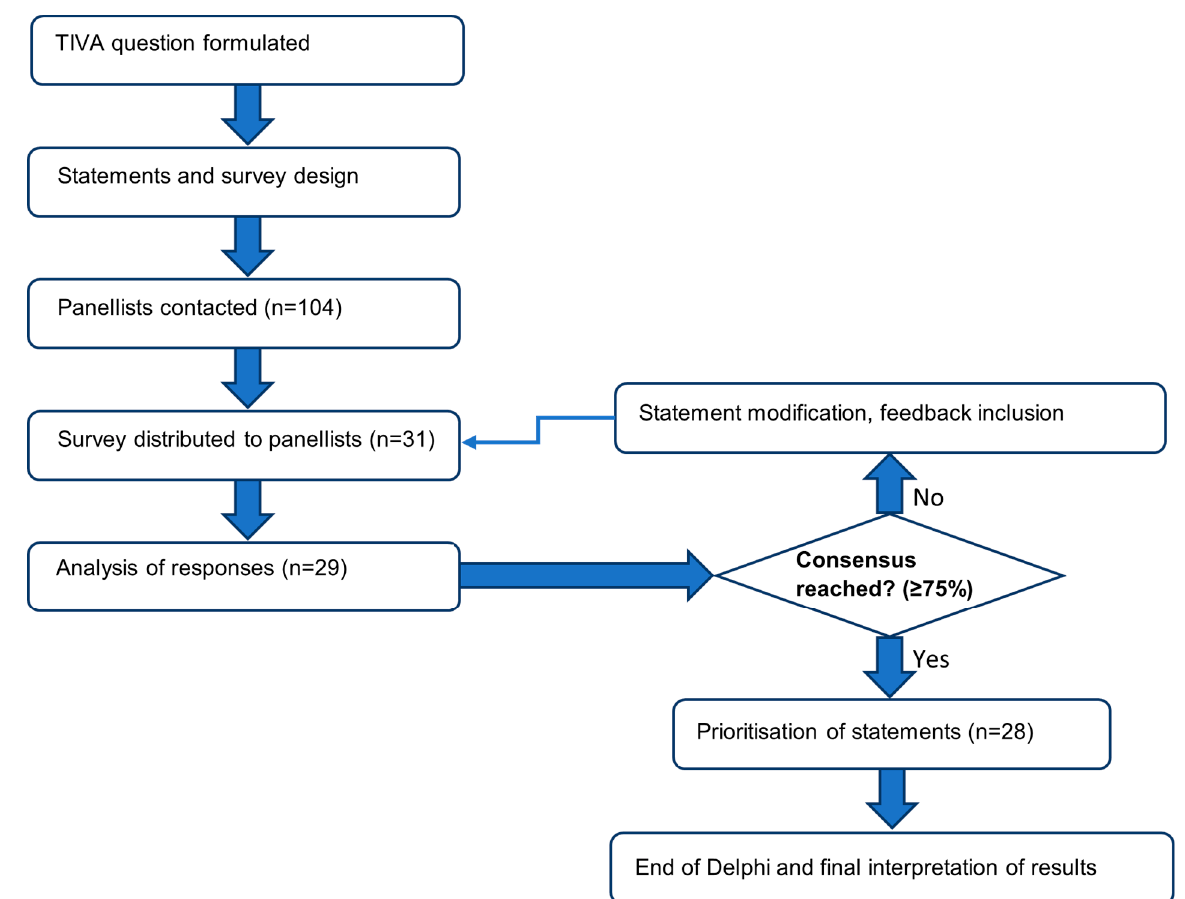
Figure 1. Flowchart depicting the process of the Delphi method.